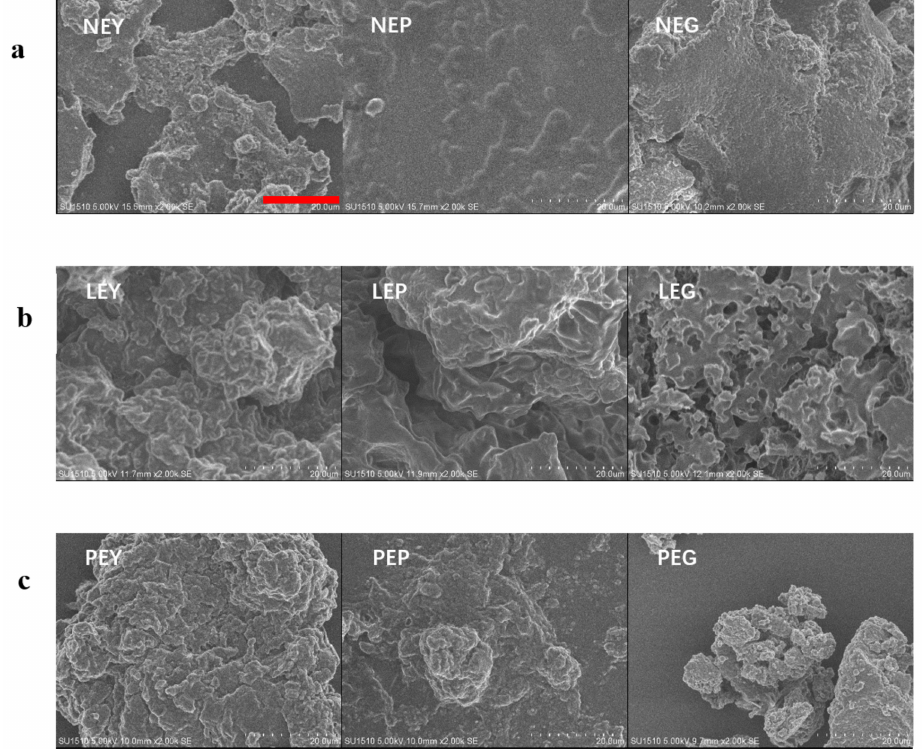
Figure 5. SEM images of sample dispersions under different treatments. ( a ) NEY, NEP and NEG (natural egg yolk, natural egg plasma and natural egg granule, respectively). ( b ) LEY, LEP and LEG (egg yolk hydrolyzed by lipase, egg plasma hydrolyzed by lipase and egg granule hydrolyzed by lipase, respectively). ( c ) PEY, PEP and PEG (egg yolk hydrolyzed by phospholipase, egg plasma hydrolyzed by phospholipase and egg granule hydrolyzed by phospholipase, respectively). The red scale bar in the image means 20.0 µ